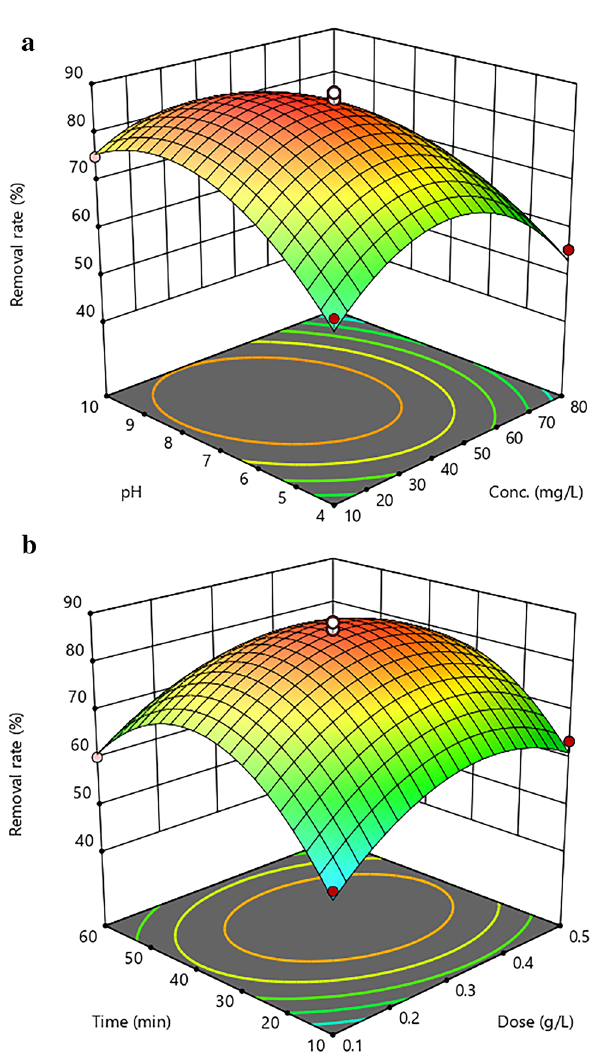
Fig. 5 Response surface plot about the effects of a pH versus MNZ and b S. platensis versus